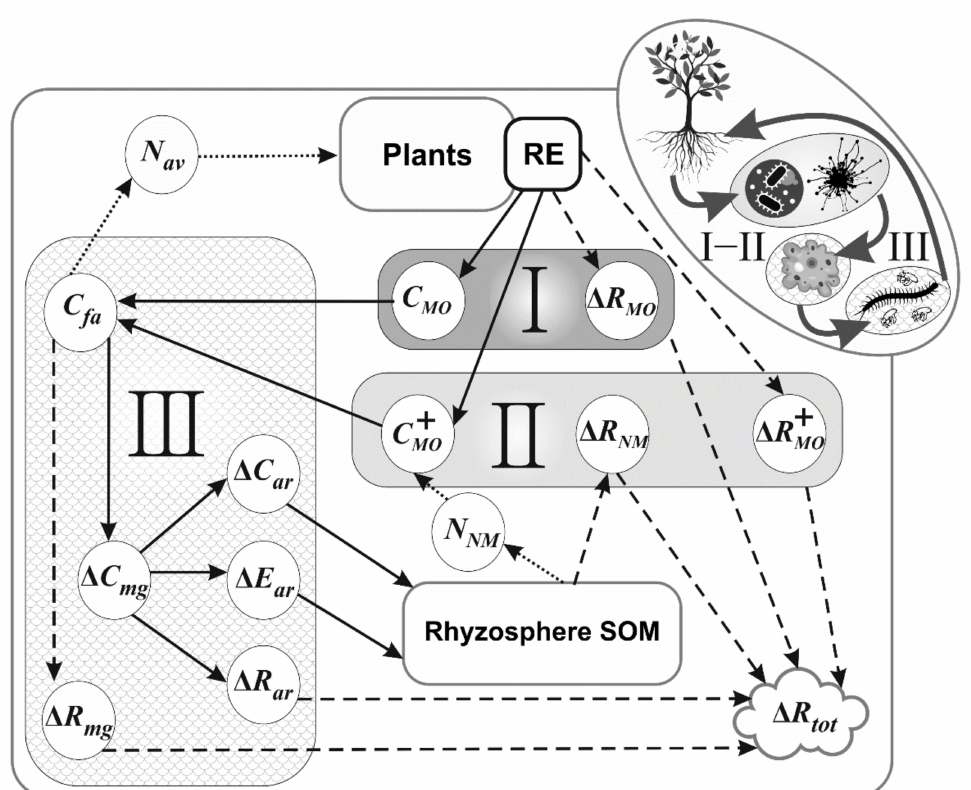
Figure 1. Conceptual structure of the rhizosphere priming model. “I” is a subroutine of root exudate (RE) consumption by microorganisms; “II” is a subroutine of nitrogen mining, and “III” refers to the soil fauna food web. The symbols are the same as in the equations in the “Model description”: “ C i ” is carbon of microorganisms and fauna biomass; “ R i ” relates to the respiration of soil biota; “ N i ” is nitrogen; “ E ” is faunal excrements. Symbol ∆ relates to the rate of the processes. Subscripts in symbols: “ MO ”—microorganisms; “NM” —nitrogen mining; “ fa ”—food for fauna; “ mg ”—microbial grazers; “ ar” —arthropods; “ tot” —total. ∆ R + is a microbial respiration at the consumption of MO excessive C of exudates. The growth of microbial biomass owing to root exudation and change of food web components are represented with solid lines, the microbial and faunal respiration with dashed lines, the nitrogen mining and N release processes with dotted line. All is in carbon (C) or nitrogen (N) mass units. The formation and flow of microbial necromass to the rhizosphere SOM is not represented here. Input and output variables of the model are represented in Table 1. The model has a daily time step. All flows (denoted with ∆ in the equations below) are calculated first, and after that the pools are changed at a single step. The parameters of the model are represented in Table